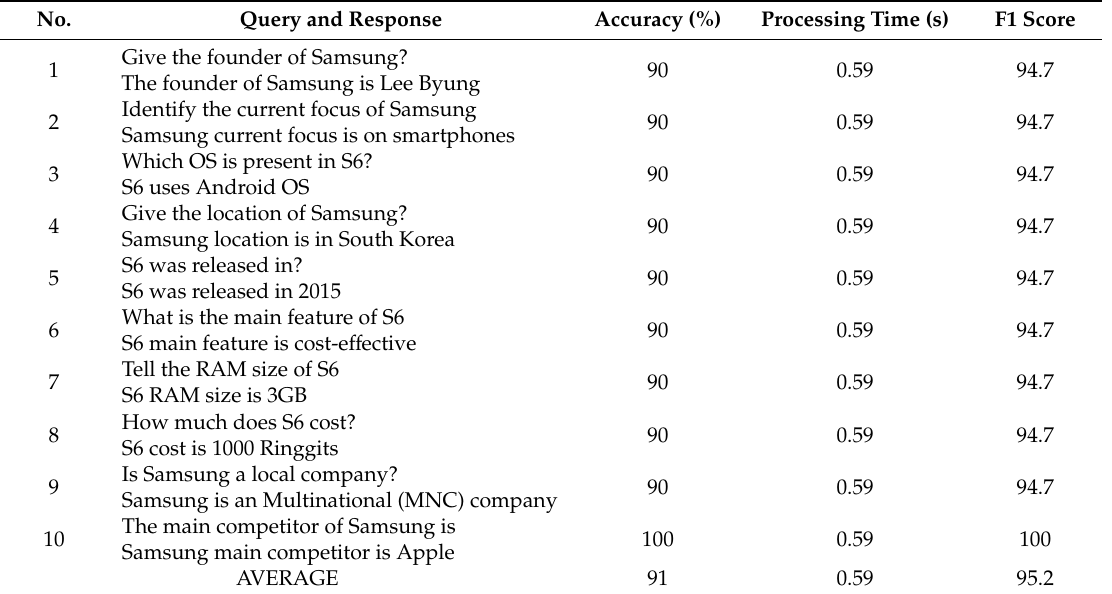
Table 4. F1 score of language